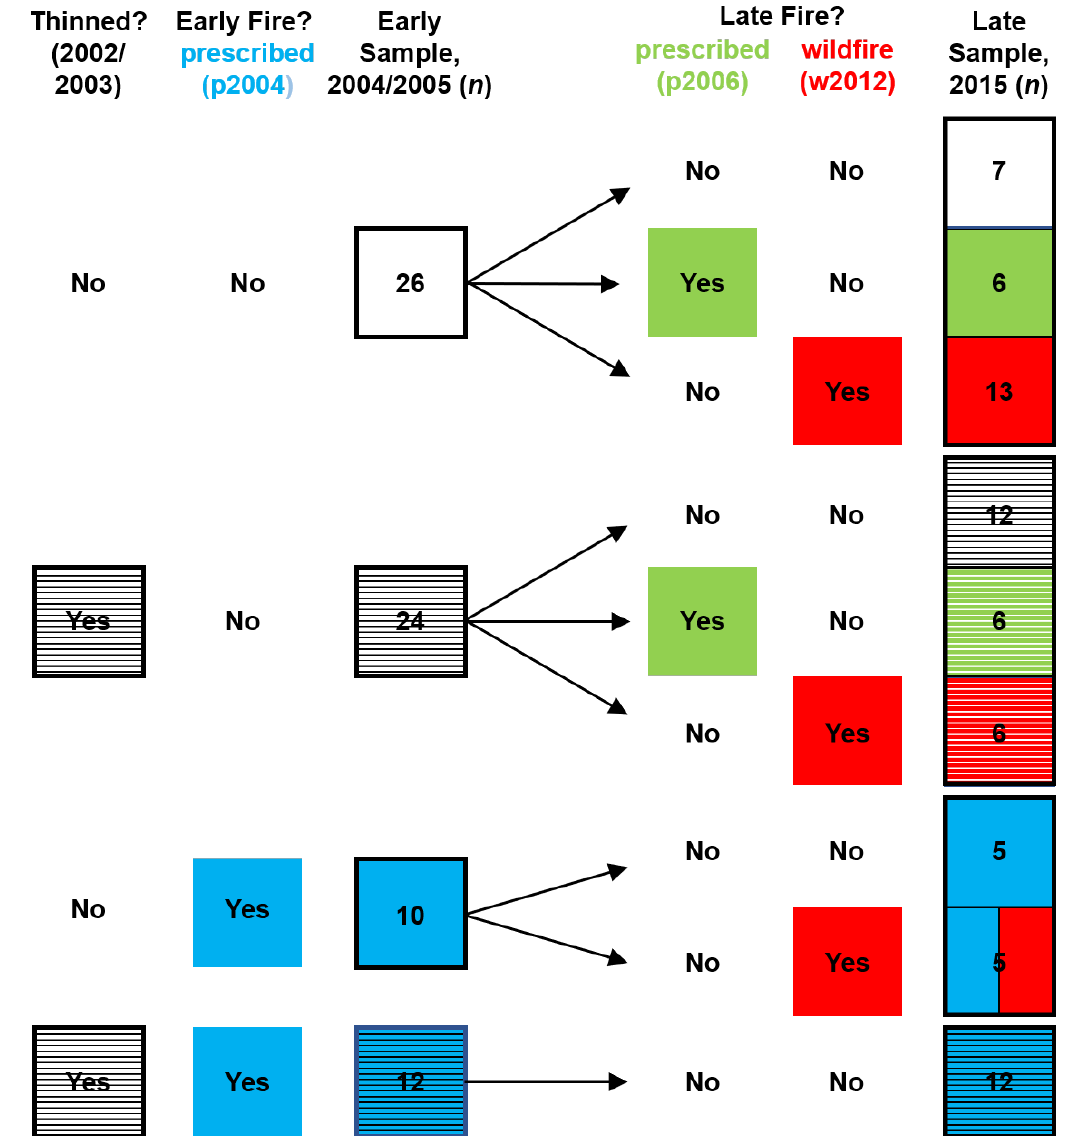
Figure 2. Schematic illustration of the diverse and changing histories of fuels treatments (thinning and prescribed burning) and wildfire among the 72 sample plots. Values ( n ) are the numbers of plots sampled ‘Early’ (overstory in 2004, regeneration in 2005) or ‘Late’ (2015). Hatching denotes the history of thinning (unthinned or thinned in 2002 / 2003). Colors denote the type and timing of fire: no fire, ’Early’ prescribed fire (2004, blue), ‘Late’ prescribed fire (2006, green), and ‘Late’ wildfire (2012, red). Multiple colors in the Late sample indicate repeated burning of some plots.